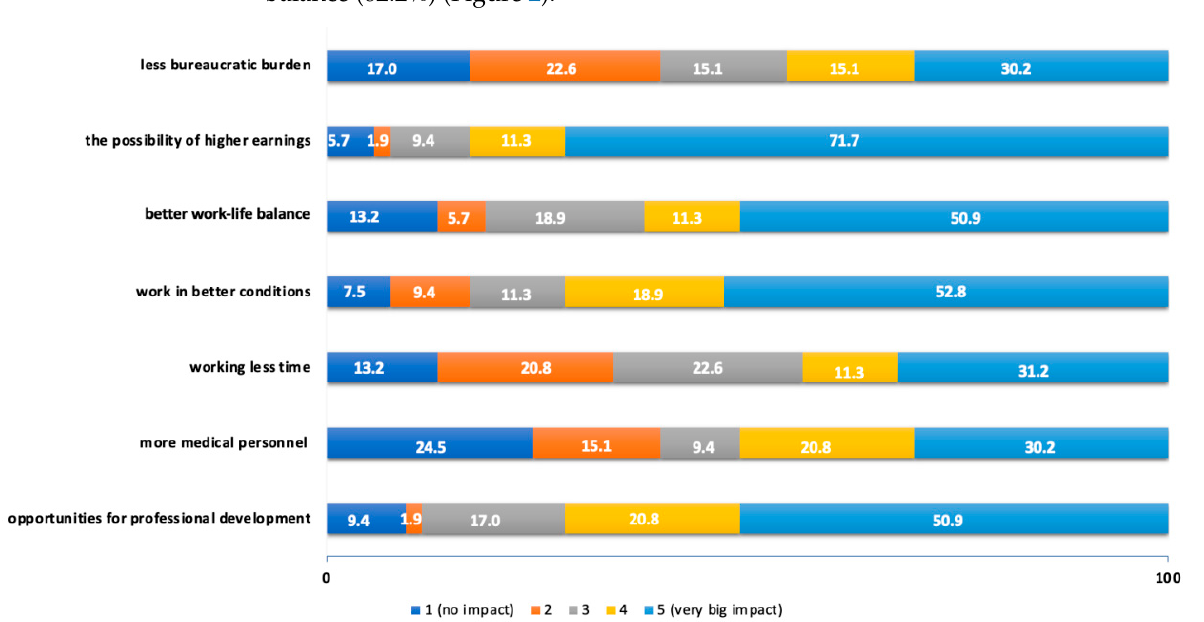
Figure 3. Assessment of the influence of push factors according to students of physiotherapy.